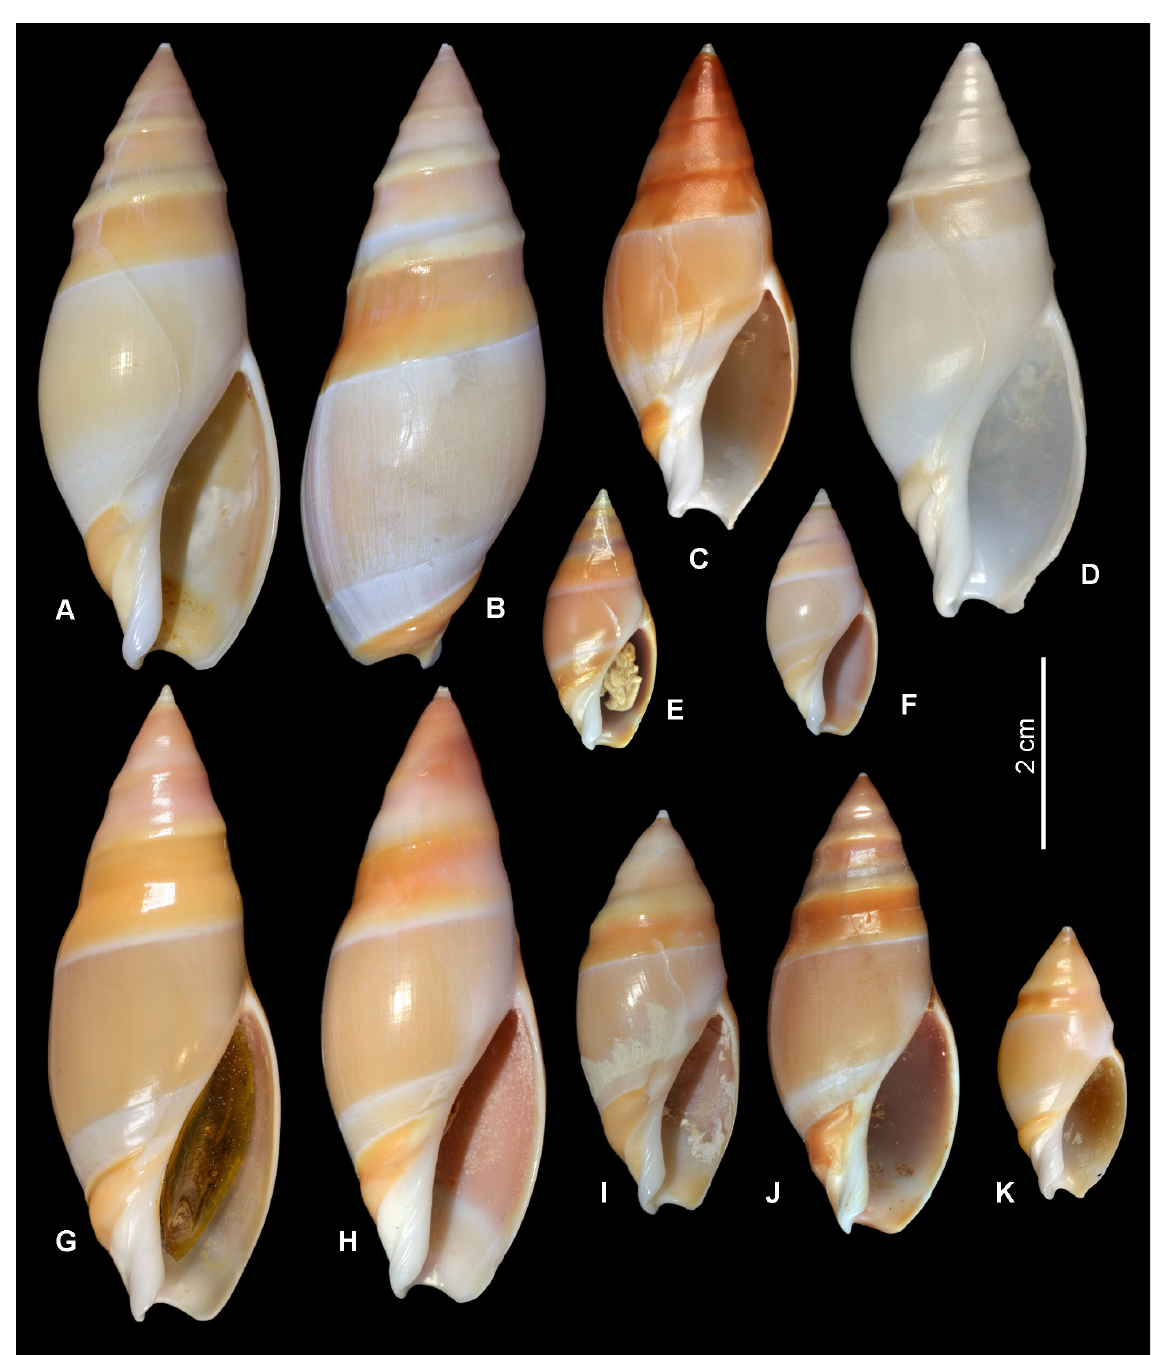
Fig. 5. Amalda hilgendorfi (von Martens, 1897). A–F . Coral Sea morph. A-B . MNHN IM-2007- 33313, SL 66 mm. C . MNHN IM-2007-33289, SL 51.3 mm. D . MNHN IM-2007-33288, SL 60.3 mm. E . MNHN IM-2013-63901, SL 27-3 mm. F . MNHN IM-2007-33312, SL 25.9 mm. G–K . Northern New Caledonia morph = A. hilgendorfi richeri Kilburn & Bouchet, 1988. G . Holotype, MNHN IM-2000- 1378, SL 66.9 mm. H . MNHN IM-2009-11916, SL 65 mm. I . MNHN IM-2009-11918, SL 43.2 mm. J . MNHN IM-2007-42675, SL 48.7 mm. K . MNHN IM-2009-11966, SL 29 mm. Shells at the same